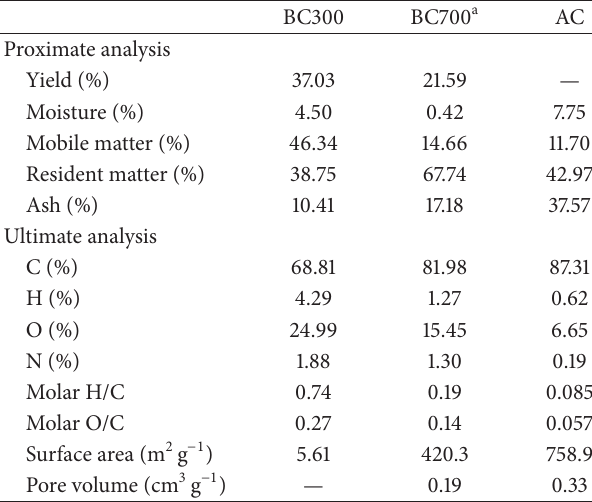
Table 1: Proximate and ultimate analyses of soybean stover derived biochars at 300 ∘ C (BC300) and 700 ∘ C (BC700) and activated carbon